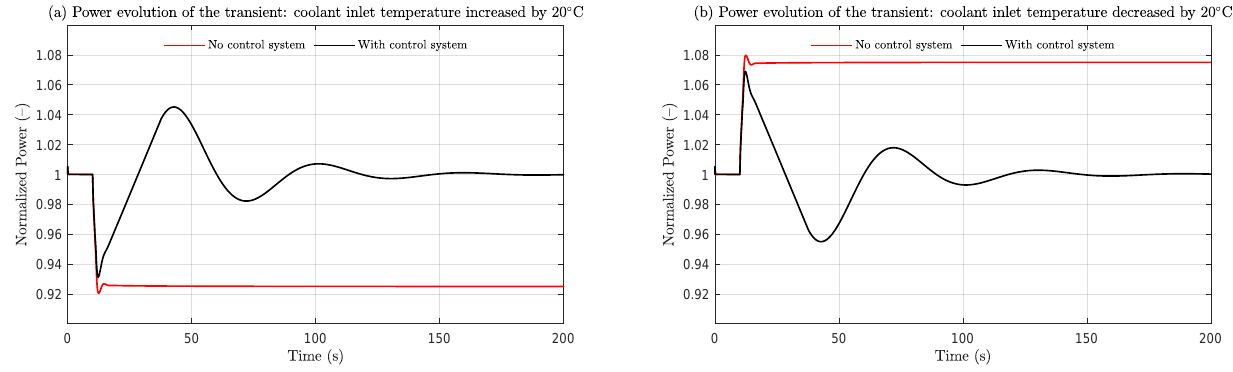
Figure 9. System response of variation in inlet temperature: ( a ) inlet temperature increased by 20 ◦ C; ( b ) inlet temperature decreased by 20 ◦